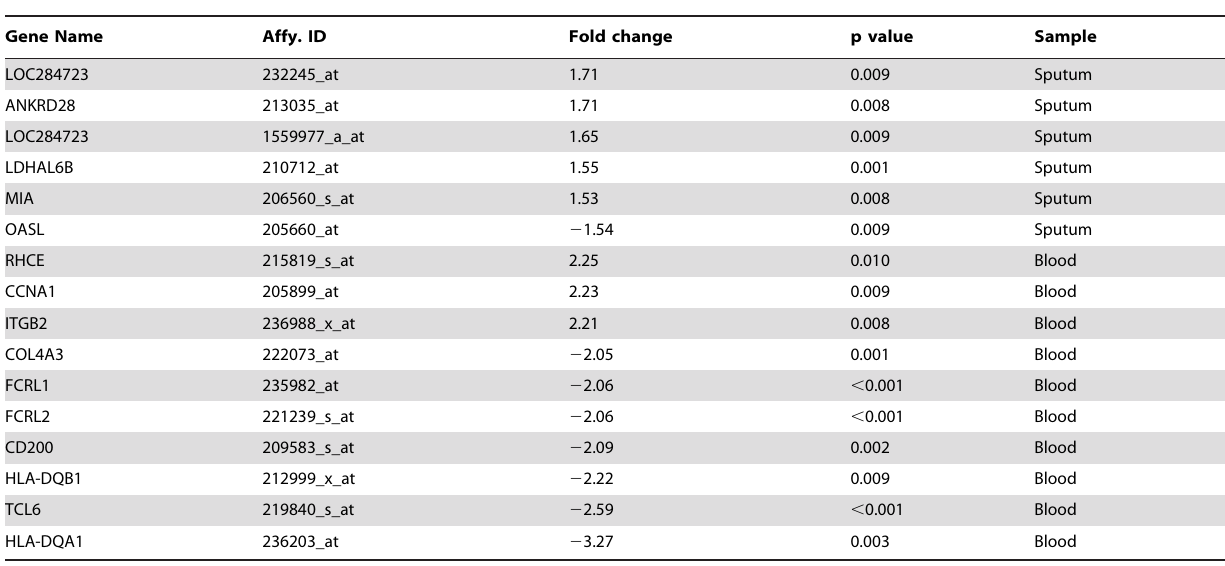
Table 2. The 10 most highly regulated genes in sputum and blood from microarray analysis; a positive fold change = increase in frequent exacerbators compared to zero exacerbators, a negative fold change = decrease in frequent exacerbators compared to zero